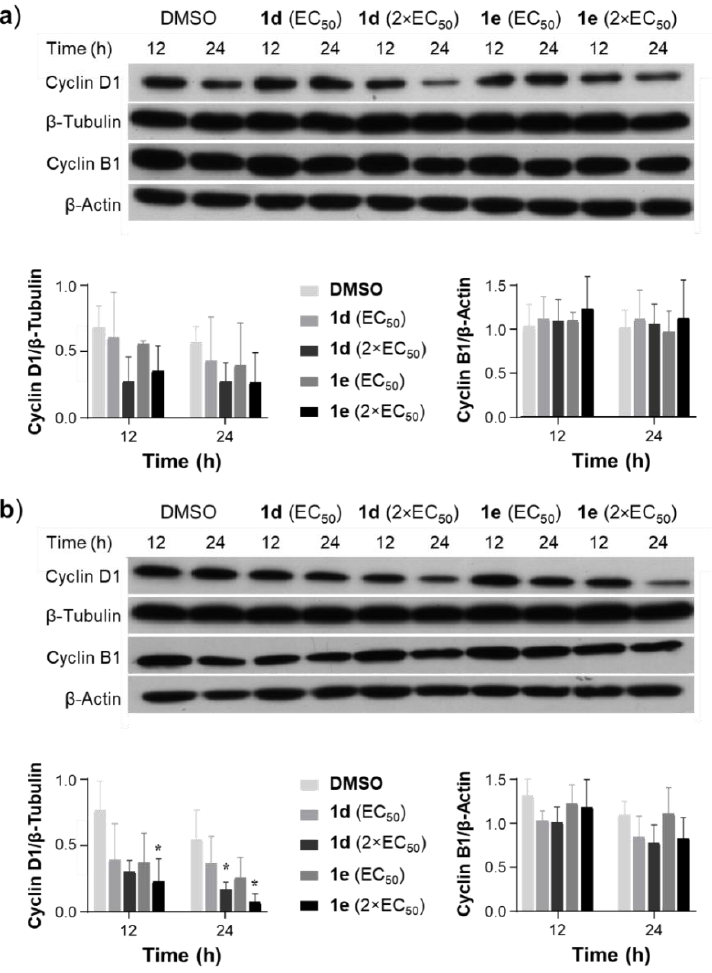
Figure 7. Effect of 1d and 1e on the expression of cyclin D1 and B1 in A549 and NCI-H522 cells. Cell lysates of ( a ) A549 and ( b ) NCI-H522 cells, which were treated with 1d and 1e at 1× and 2× the EC 50 concentrations for 12 and 24 h, were subjected to Western blotting with specific antibodies for cyclin D1 and B1. Vehicle control cells were incubated with DMSO (0.5%). Blots shown are representative of n = 3. Scanning densitometry of the ratio of cyclin D1 to β -tubulin and cyclin B1 to β -actin in A549 ( a ) and NCI-H522 ( b ) cells. Bars represent mean ± SEM ( n = 3). Data were analyzed with a two-way ANOVA coupled with a Bonferroni post hoc test. * Indicates significant differences relative to control ( p <